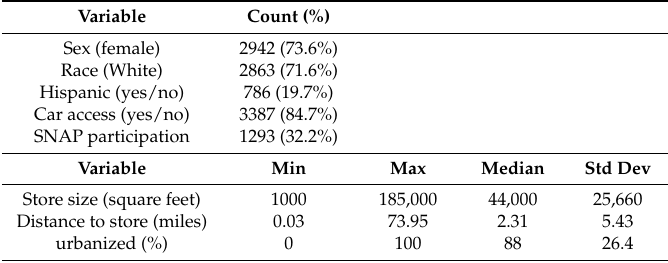
Table 1. Characteristics of households, primary food shoppers, and residential location.